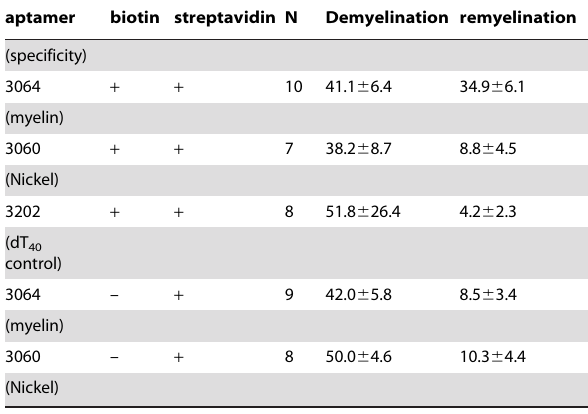
1 Table indicates lesion status, by animal, after blinded review of neuropathology. N: number of mice. Data express percentage of spinal cord quadrants showing at least 75% of the lesion was remyelinated (mean + / 2 SEM). Statistical comparisons: P , 0.002 remyelination - (ANOVA on Ranks). Dunn’s comparison to 3202 (control) showed statistical difference (p , 0.05) against 3064 with biotin/streptavidin. There was no statistically significant difference in remyelination between 3202 control and 3064 without biotin.